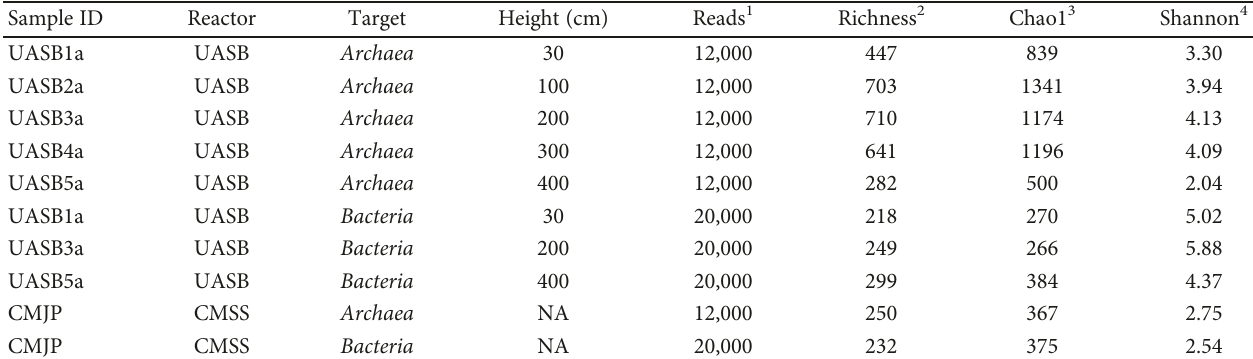
Table 1: Reads and diversity indices obtained from the high-throughput analysis of archaeal and bacterial 16S rRNA gene amplicons for sludge samples taken from tetramethylammonium-degrading CMSS and UASB